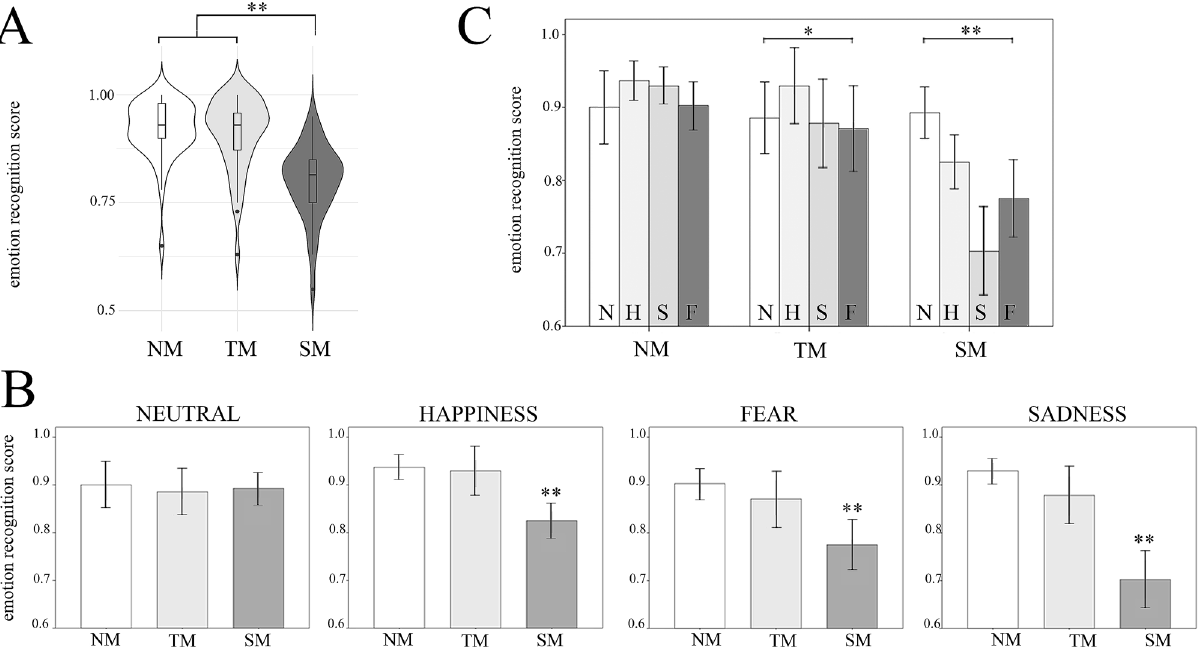
Figure 2. Emotion recognition task. ( A ). Violin plots depicting the accuracy of the emotion recognition task, regardless of the posed emotion. Results show a significant main effect of Condition (TM, SM, NM). Emotion recognition in SM was significantly worse than both NM and TM, while no difference was found between NM and TM. ( B ). The figure illustrates, for each emotion, the impact of the presence/type of mask. Significant effects were found for Happiness, Sadness and Fear, with a significant drop for SM with respect to both TM and NM. No effect was found for the Neutral faces. ( C ). The figure illustrates, for each condition, which emotions were more affected by the presence/type of mask. Results show a mild but significant main effect of Emotion in TM and a stronger effect in SM, but no effect in NM. See Table 1 for post-hoc results. Error bars indicate confidence intervals. Horizontal bars indicate significant results (* p < .01; ** p < .001). Abbreviations: N: neutral, H: happiness, S: sadness, F: